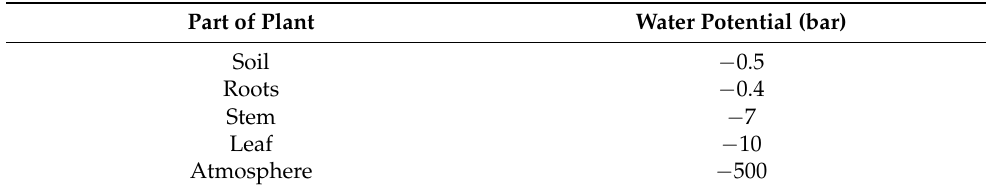
Table 3. Water potentials in different plant which support water movement in soil–plant–atmospheric